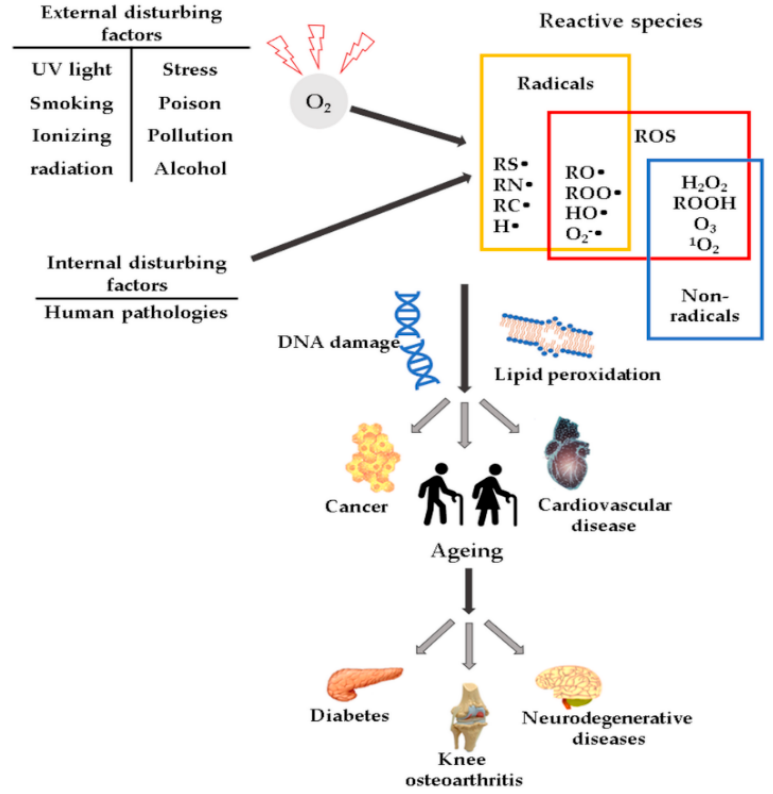
Figure 1. Schematic representation of ROS and their